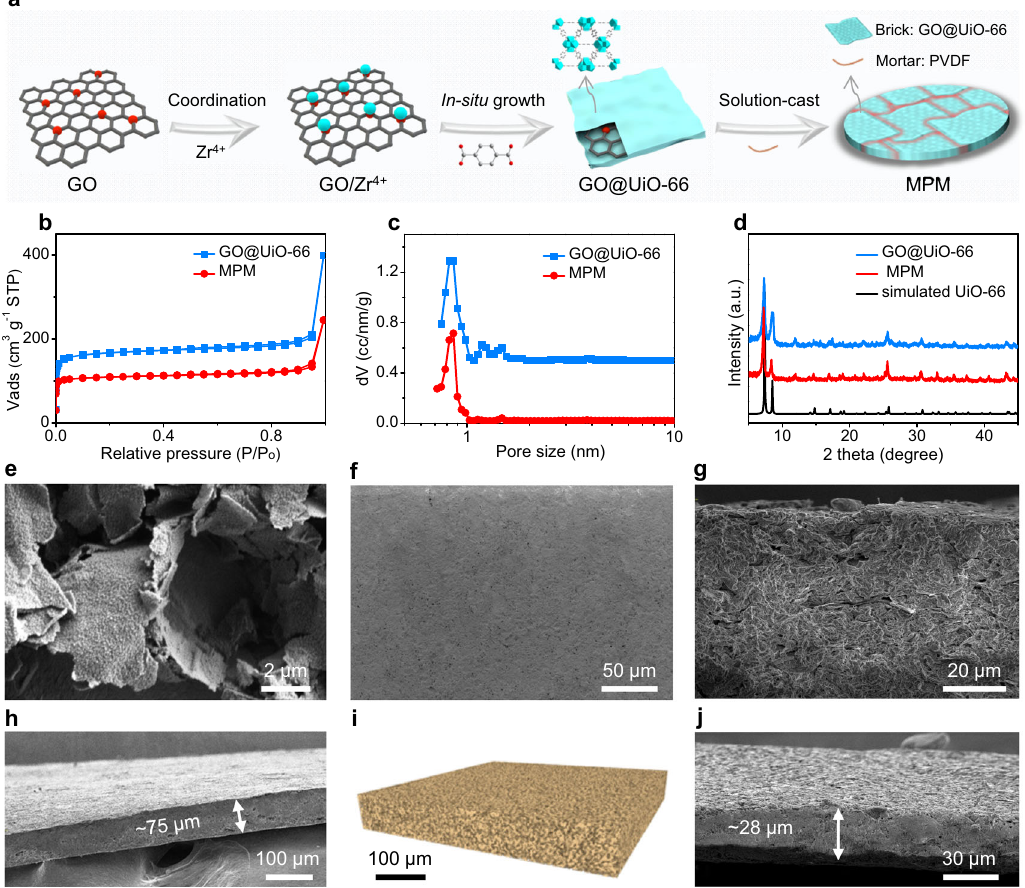
Fig. 2 Characterization of MPMs. a Illustration of fabrication process of MPMs, in which GO@UiO-66 nanosheets and PVDF binder working as the brick and mortar respectively. N 2 sorption isotherm curves ( b ), pore size distributions ( c ), and XRD patterns ( d ) of simulated UiO-66, GO@UiO-66, and MPM fabricated based on GO@UiO-66. e SEM images of GO@UiO-66. Top ( f ) and cross-sectional ( g , h ) SEM views of a representative MPM with different magni fi cations. i Nano-CT reconstruction of MPM. j Cross-sectional SEM view of a representative thin